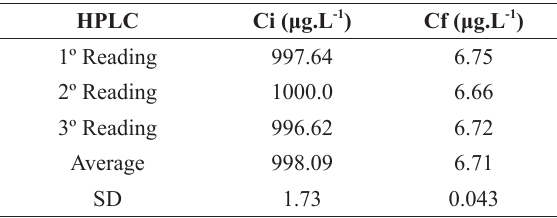
Quantitative results obtained by chromatographic analysis of individual gestodene solution before and after removal by CHT.